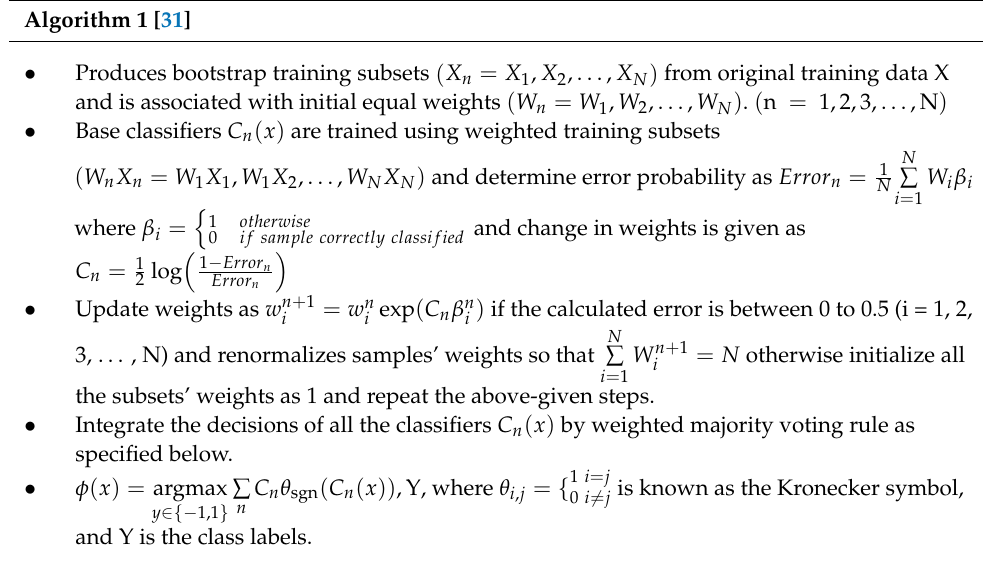
Figure 1. A generalized workflow of the AdaBoost